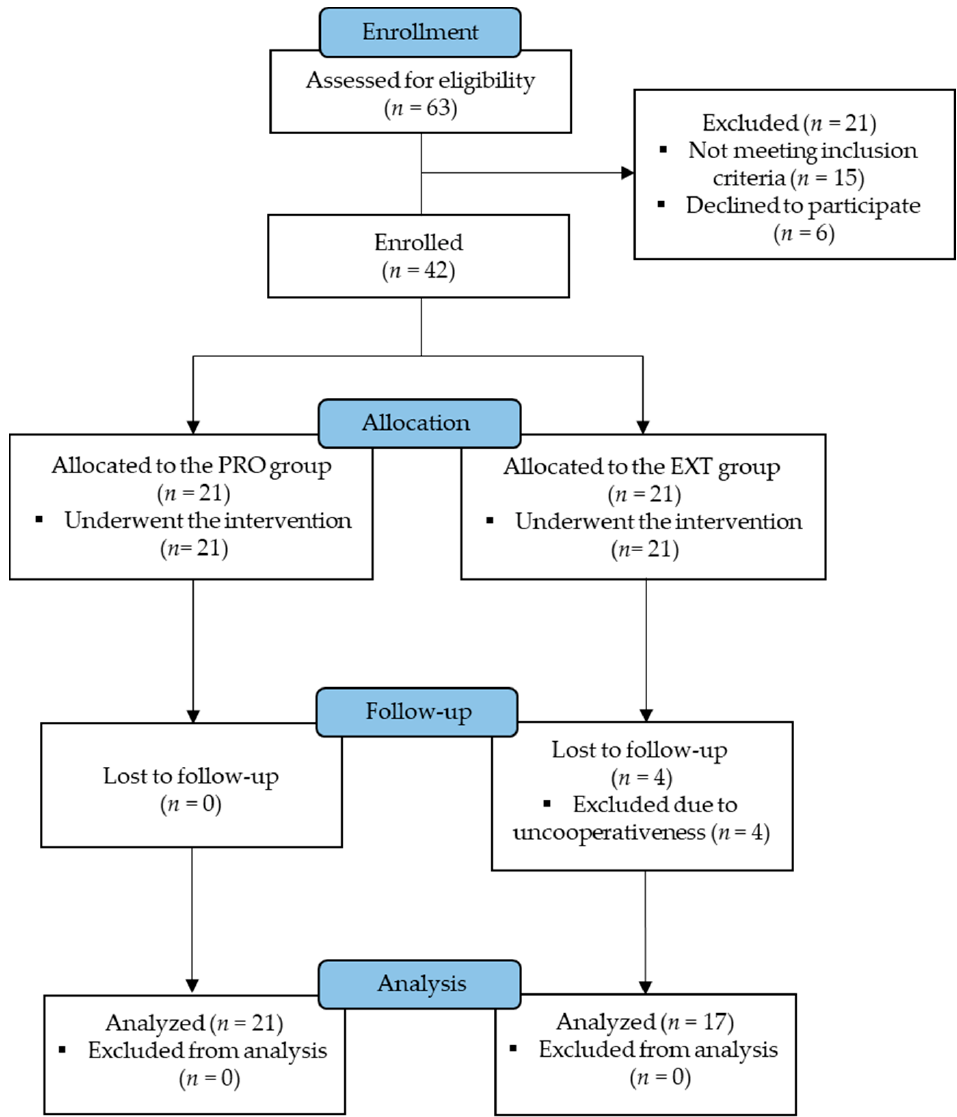
Figure 1. The flowchart of the trial according to the Consolidated Standards of Reporting Trials (CONSORT, non-randomized). Table 2. Changes of the clinical outcomes after the intervention.